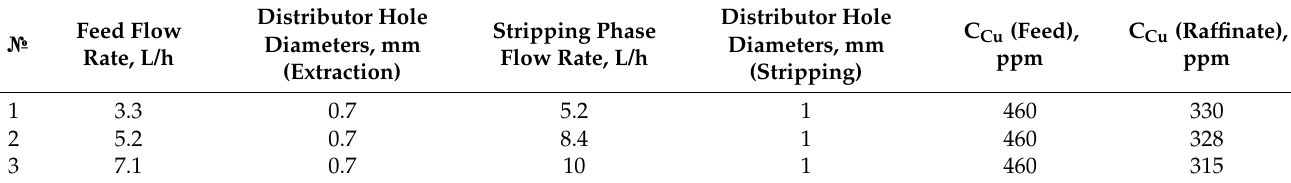
Table 3. Results and conditions of experiments conducted in the large apparatus.